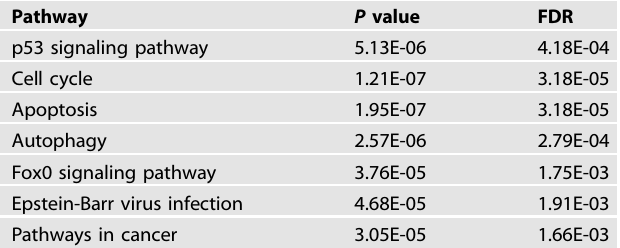
Table 2. ORA-KEGG pathways transcriptionally regulated in NOKs and